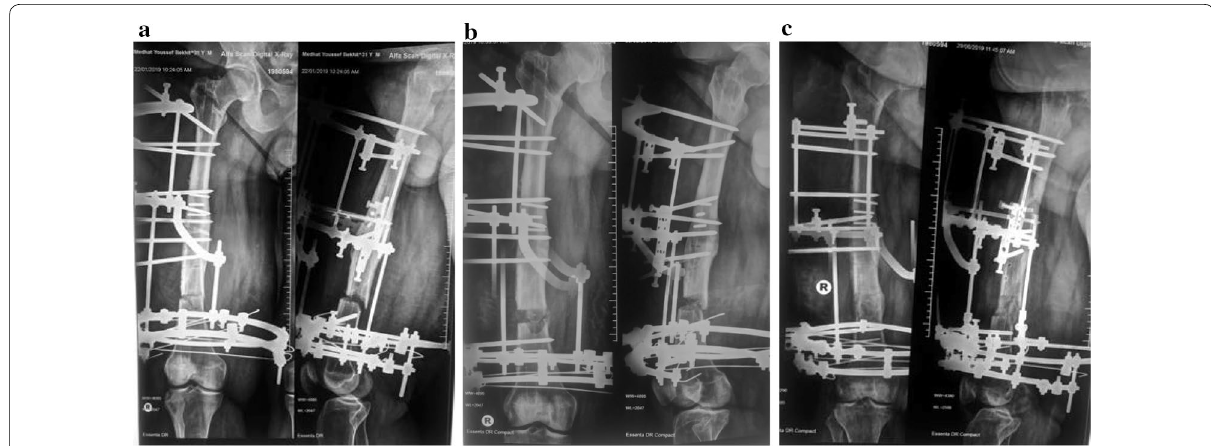
Fig. 2 a Femoral lengthening case during the latency phase after corticotomy. b Distraction phase. c Consolidation